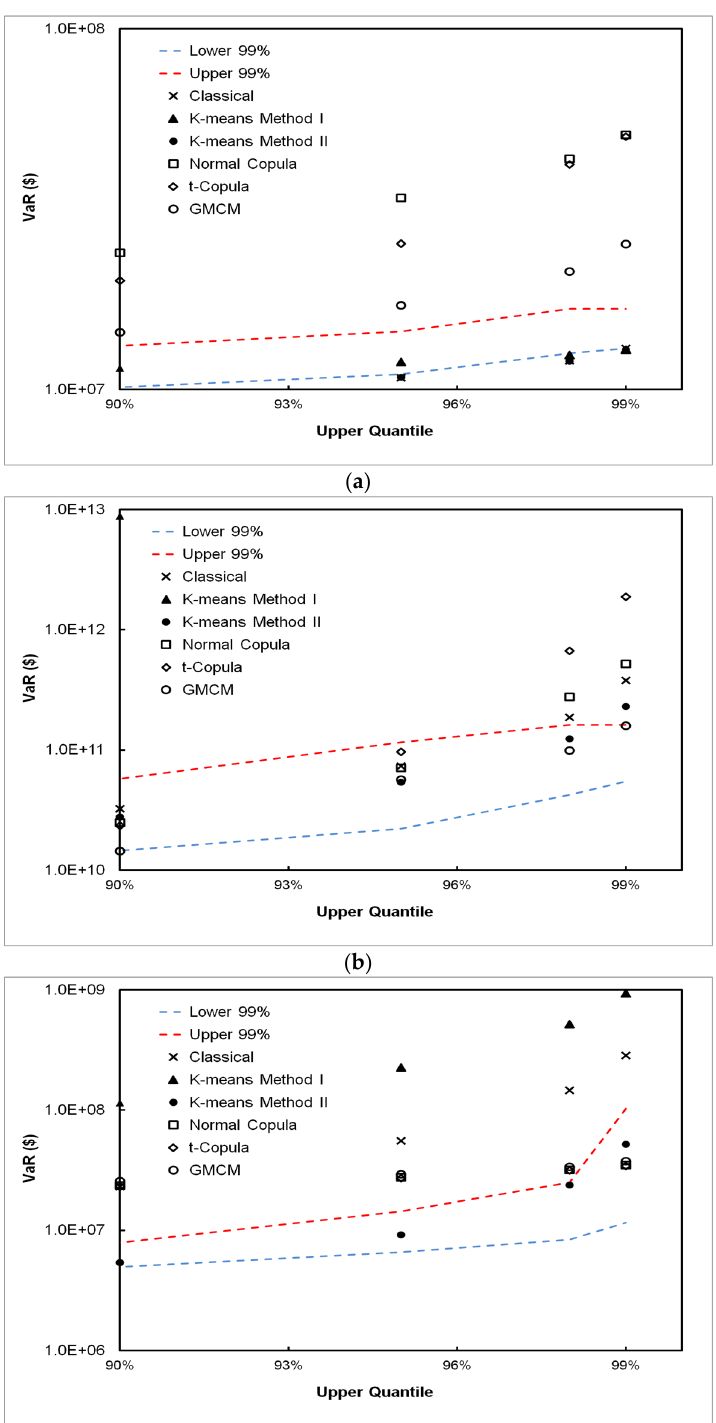
Figure 10. VaR estimates by the classical, DPFS, and CPFS methods for the S & P 500 ( a ) and DJIA data ( b ). DPFS Methods (I) and (II) works the best compared to the historical bootstrap VaR while the classical methods underestimates the historical bootstrap VaR for Standard & Poor’s (S & P) 500. On the other hand, for the Dow Jones industrial average (DJIA), both DPFS and classical approach estimate the historical bootstrap VaR to within the 99% confidence bands.